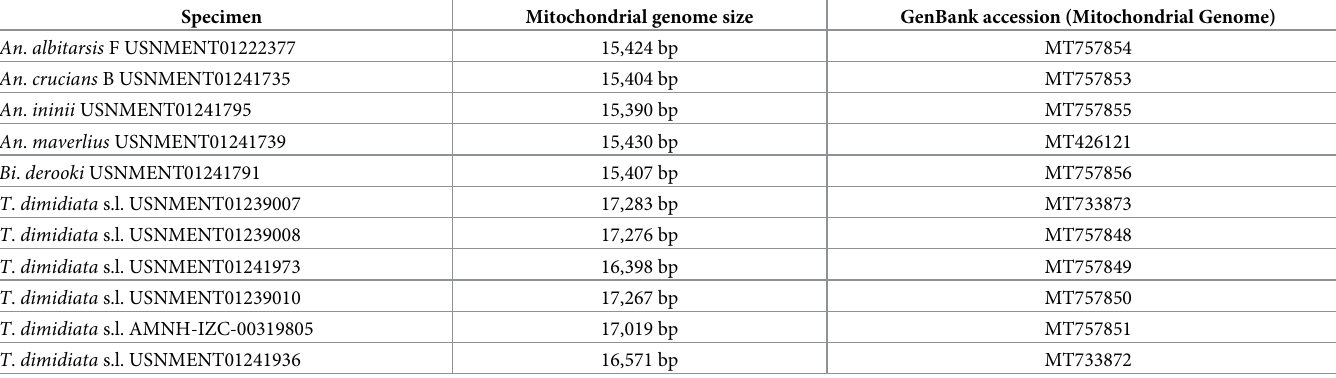
Table 3. Recovered mitochondrial genome sizes and their respective GenBank accession numbers.